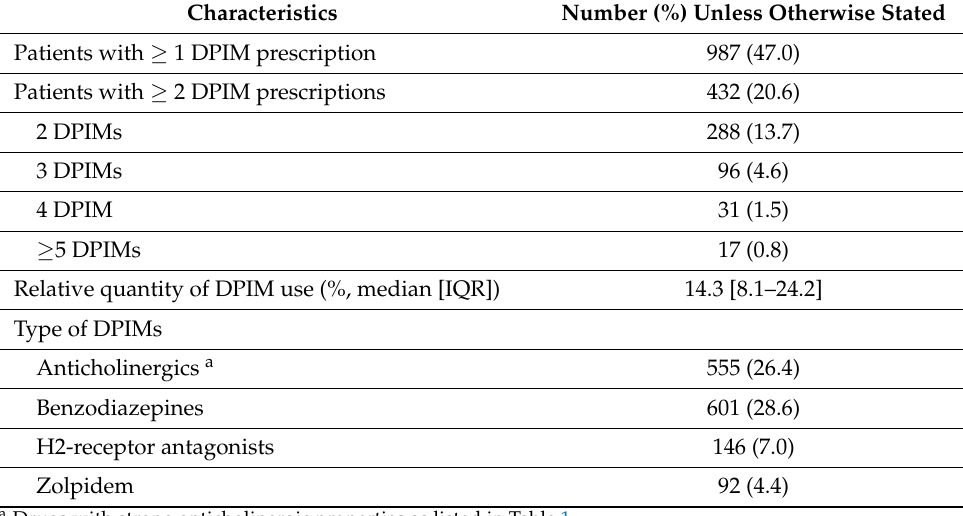
Table 3. Prevalence of DPIM use in the study population ( n =